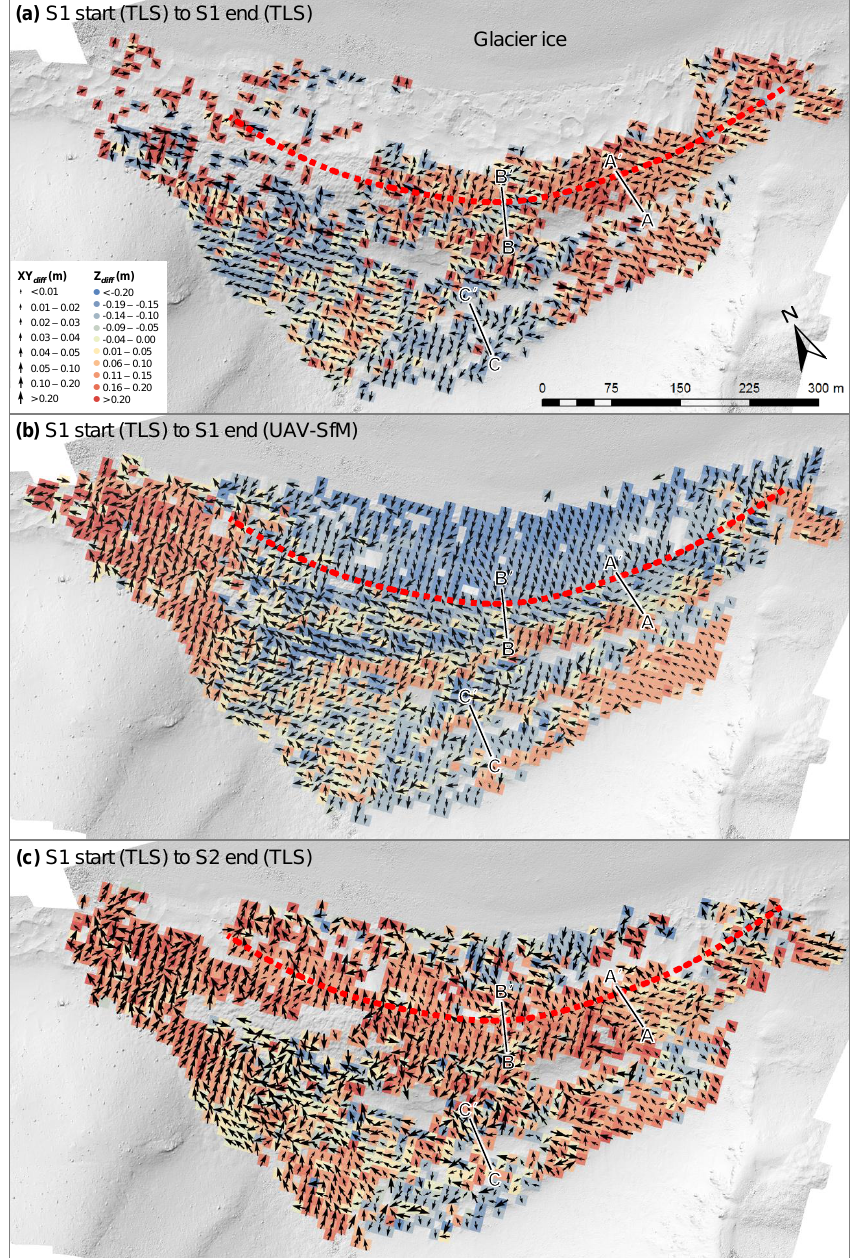
Figure 6. Change detection mapping for (a, b) intra-annual (season 1 start to season 1 end) and (c) annual (season 1 start to season 2) differencing epochs. Horizontal difference vectors ( XY diff ) are scaled by magnitude and oriented according to the direction of change. The vertical component of 3-D change ( Z diff ) is shown in the background. Transects A–C denote the location of moraine surface profiles displayed in Figs. 3 and 4. Red dashes on all panels shows the approximate location of primary moraine ridge crest.